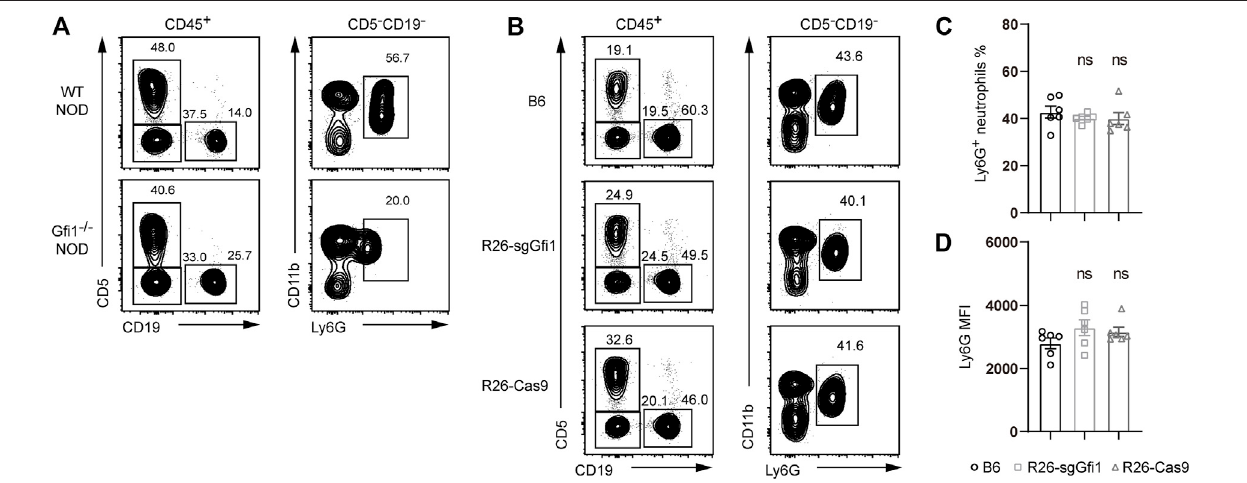
FIGURE 2 | Ly6G expression in G fi 1 − / − NOD mice, Rosa26 U6-sgRNA-G fi 1 , and R26-Cas9 B6 mice. (A) Flow cytometric analyses of peripheral blood from G fi 1 − / −